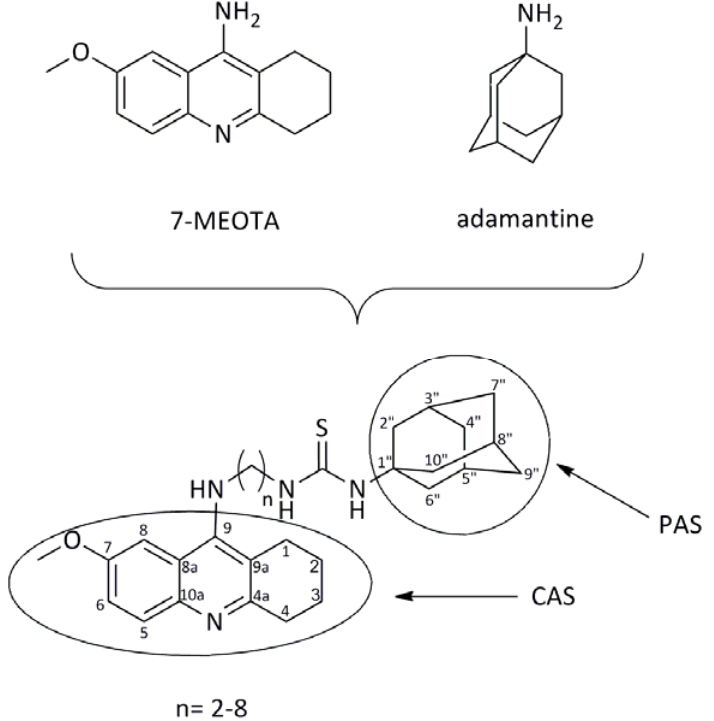
Figure 2. Design strategy of novel dual